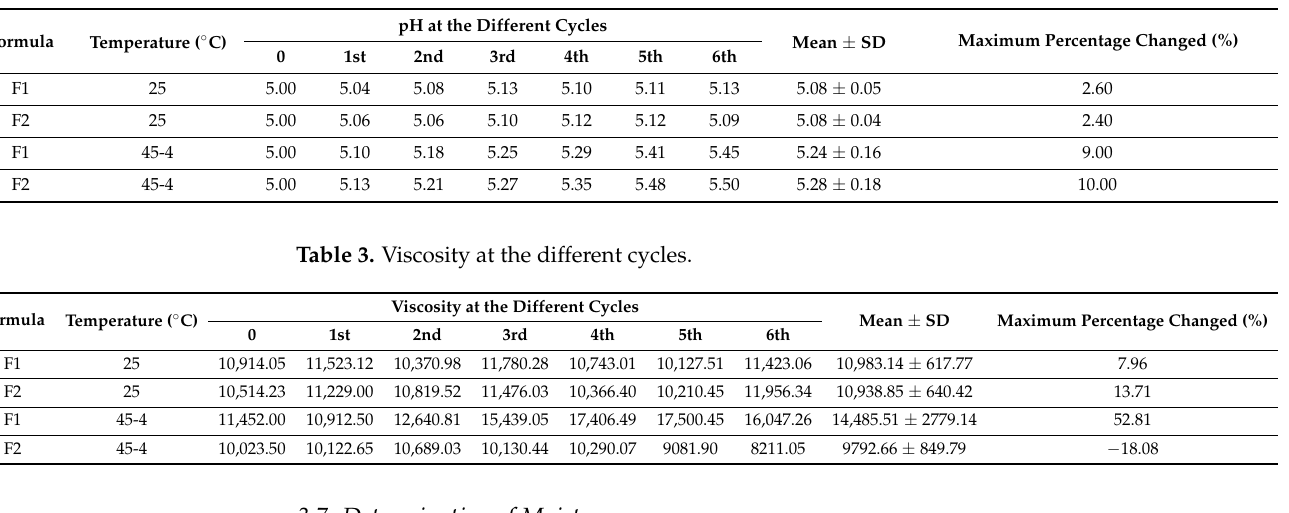
Table 2. pH values at the different cycles.